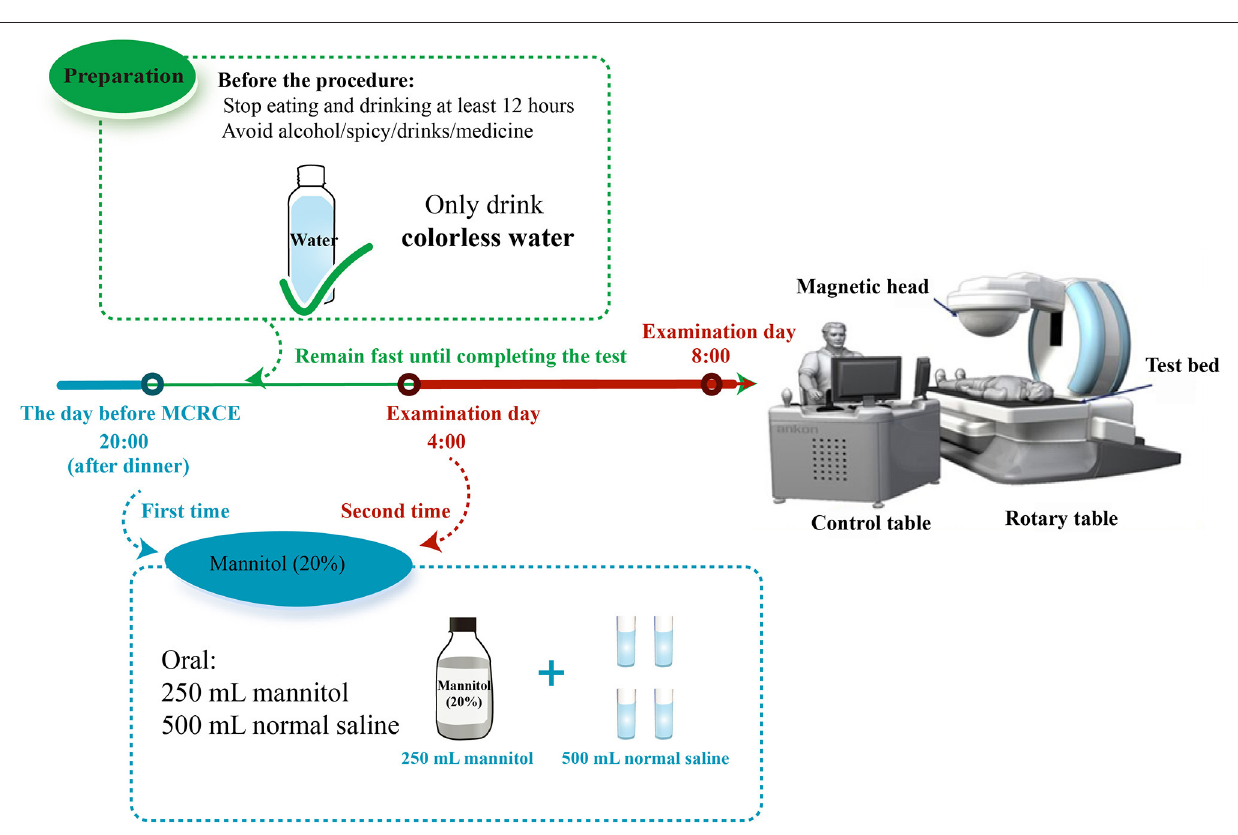
Frontiers in Medicine |